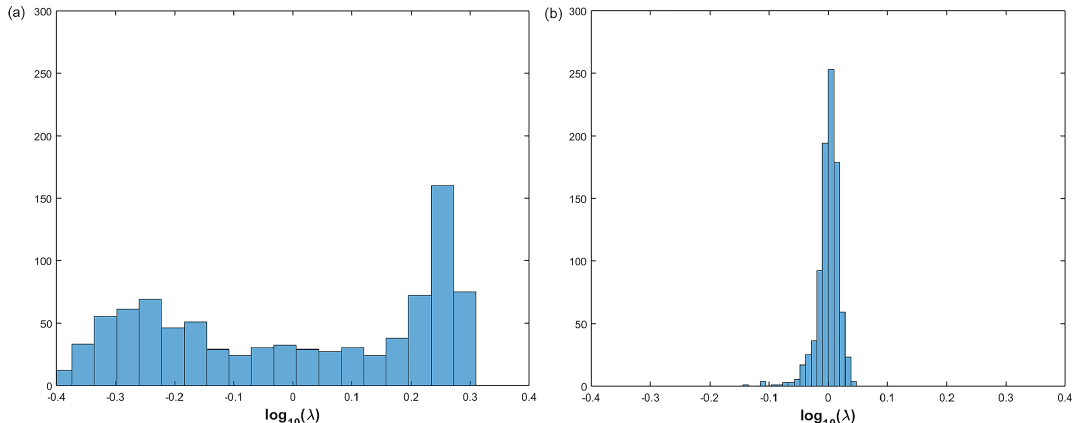
Figure 10. Histograms of the retention scaling parameter (log 10 ˆ λ i ) for Lower Saxony (left) and North Rhine-Westphalia